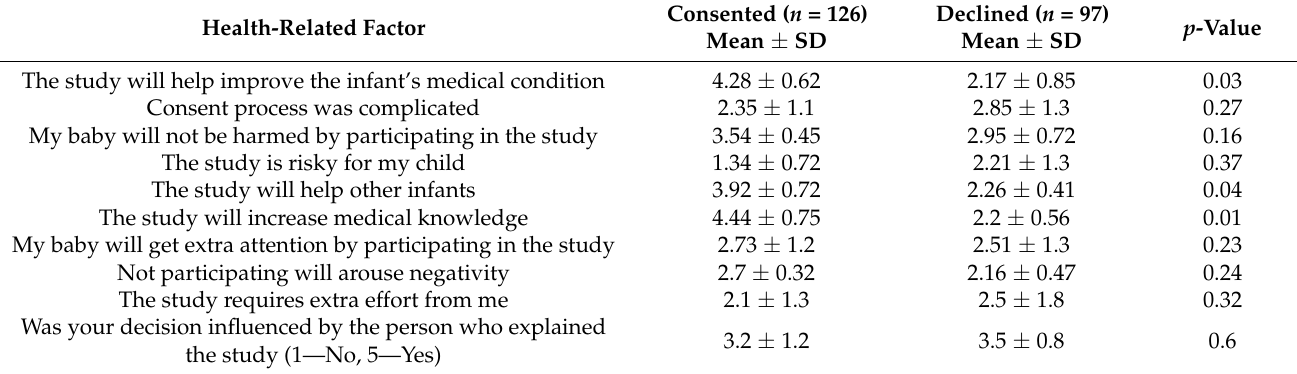
Table 1. Health factors related to consenting or declining to participate in music therapy intervention studies. Health-Related Factor